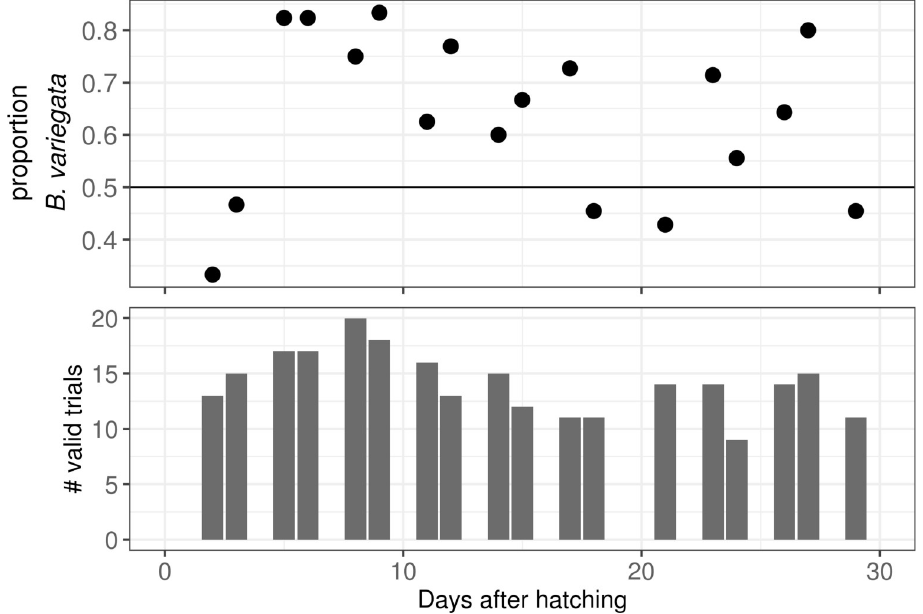
Fig 2. Relative predation risk and number of valid trials per day. A. The proportion of tadpoles consumed that were B . variegata . Tadpole age (days after hatching) is plotted on the x-axis. Each data point gives the proportion for one experiment day. B. The number of valid trials (out of 20) per experiment